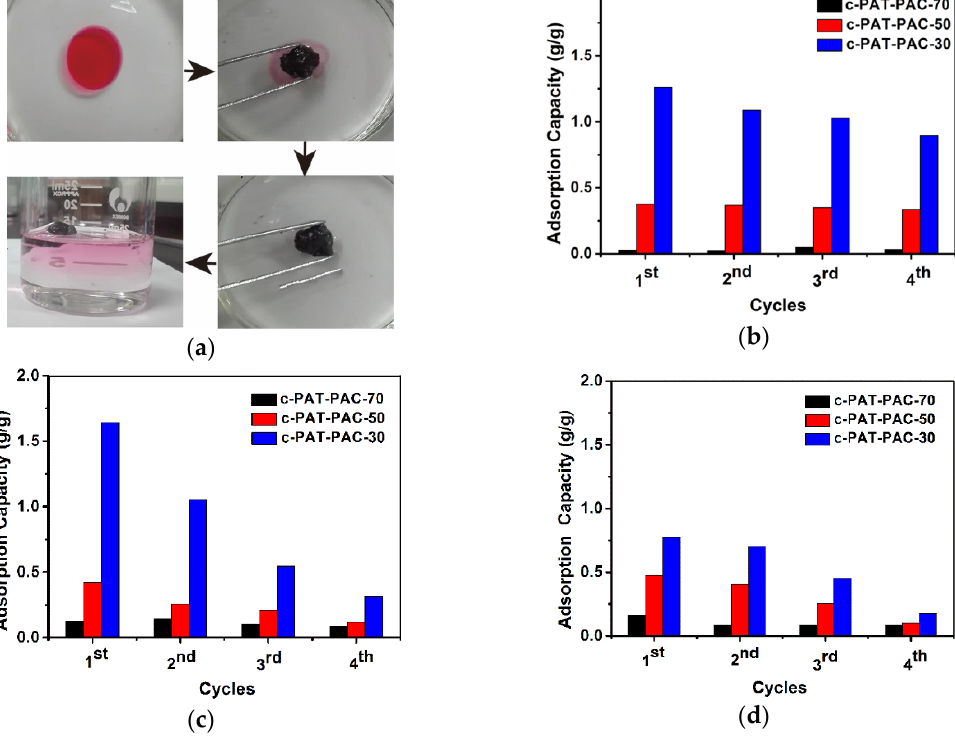
Figure 9. ( a ) Removal of spilled oil film (paraffin oil) from water by carbon monoliths and adsorption capacities of carbon monoliths for ( b ) acetone, ( c ) paraffin oil, and ( d ) soybean